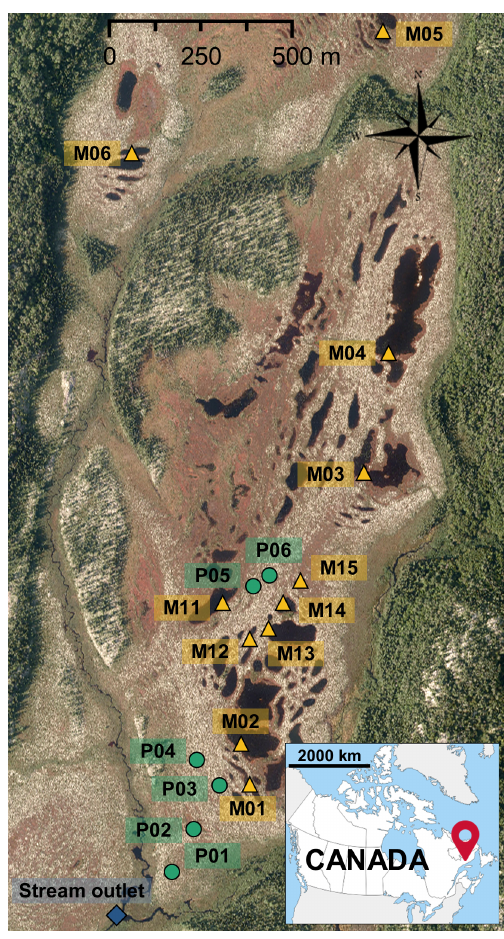
Figure 1. Aerial view of the Bouleau peatland with the location of the sampling sites (green dots: wells for peat porewater; yellow triangles: pools; blue diamond: stream outlet). The aerial photo was provided by